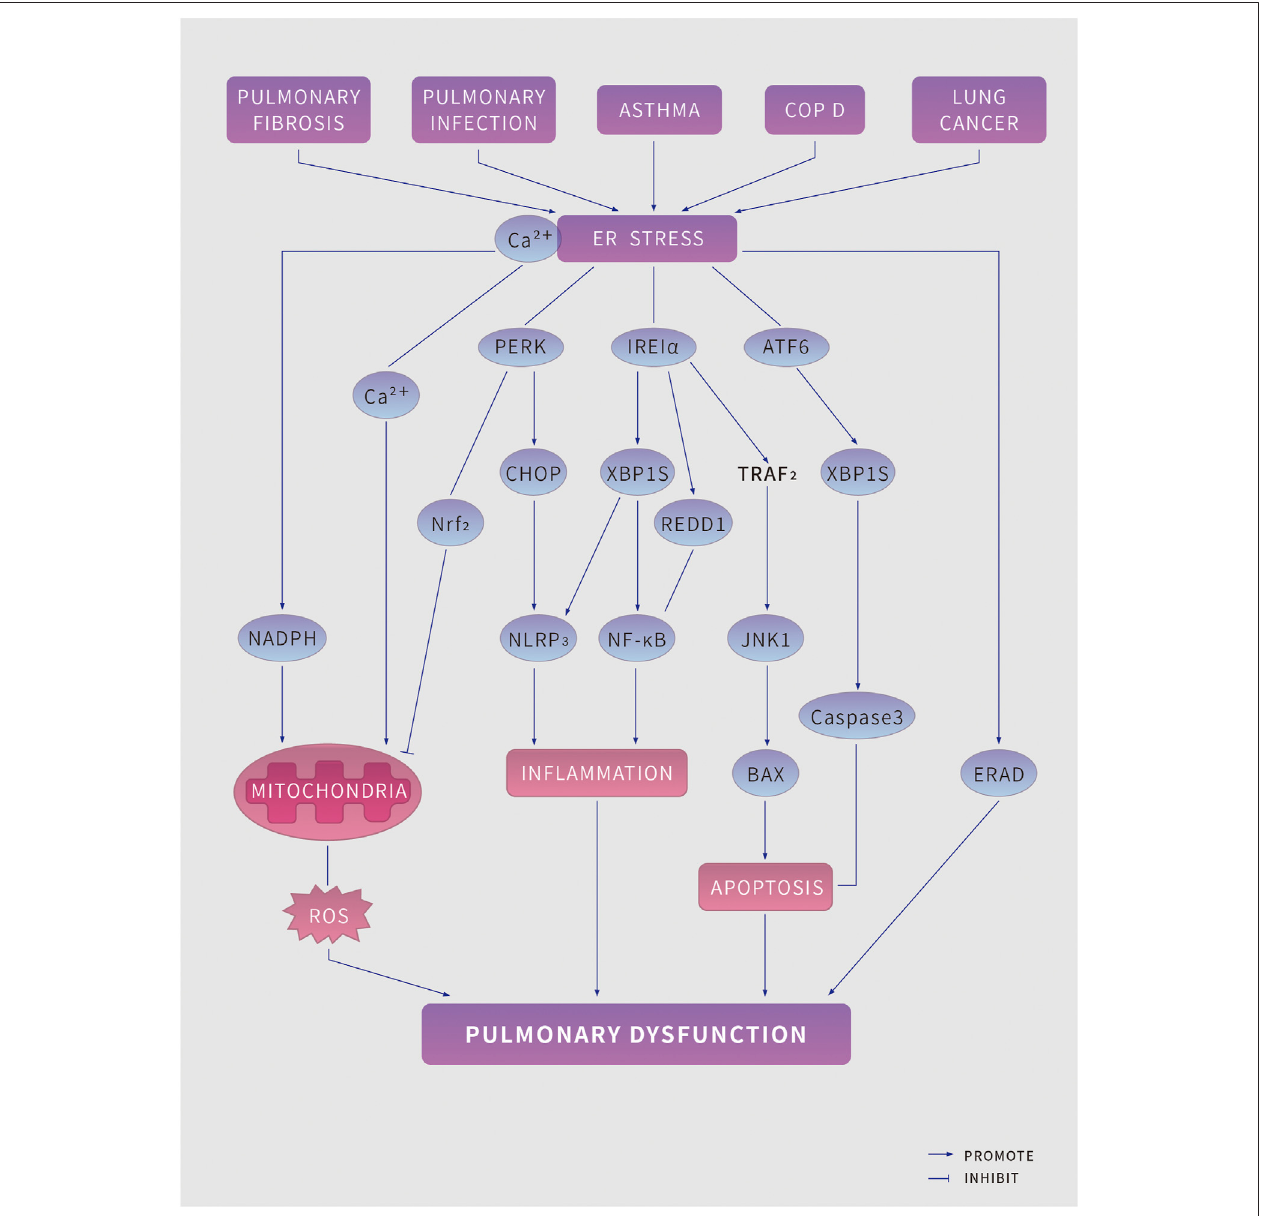
FIGURE 2 | ER stress in pulmonary disease. Pulmonary pathologies, including pulmonary fi brosis, pulmonary infection, asthma, Chronic obstructive pulmonary disease and lung cancer lead to endoplasmic reticulum (ER) stress and induce the unfolded protein response (UPR) (which has three branches, mediated by protein kinase RNA-like ER kinase (PERK), Inositol-requiring protein 1 α (IRE1 α ) and activating factor 6 (ATF6) to tackle ER stress. However, if the UPR fails to restore ER homeostasis,itmightinduceriskfactorsforpulmonarydisease,includingincreasedreactiveoxygenspecies(ROS)production,in fl ammation,andapoptosis,which furtheraggravatepulmonarydisease.BAX,BCL-2-associatedXprotein;CHOP,C/EBPhomologousprotein;ERAD,ER-associateddegradation;JNK1,JUNN-terminal kinase 1; The NK-kappa B, nuclear factor kappa B predominate; NLRP3, NACHT, LRR and PYD domains-containing protein 3; NADPH, nicotinamide adenine dinucleotide phosphate; NRF2, nuclear factor erythroid 2-related factor 2; REDD1, protein regulated in development and DNA damage response 1; TRAF2, TNF receptor associated factor 2; XBP1s, spliced X-box-binding protein